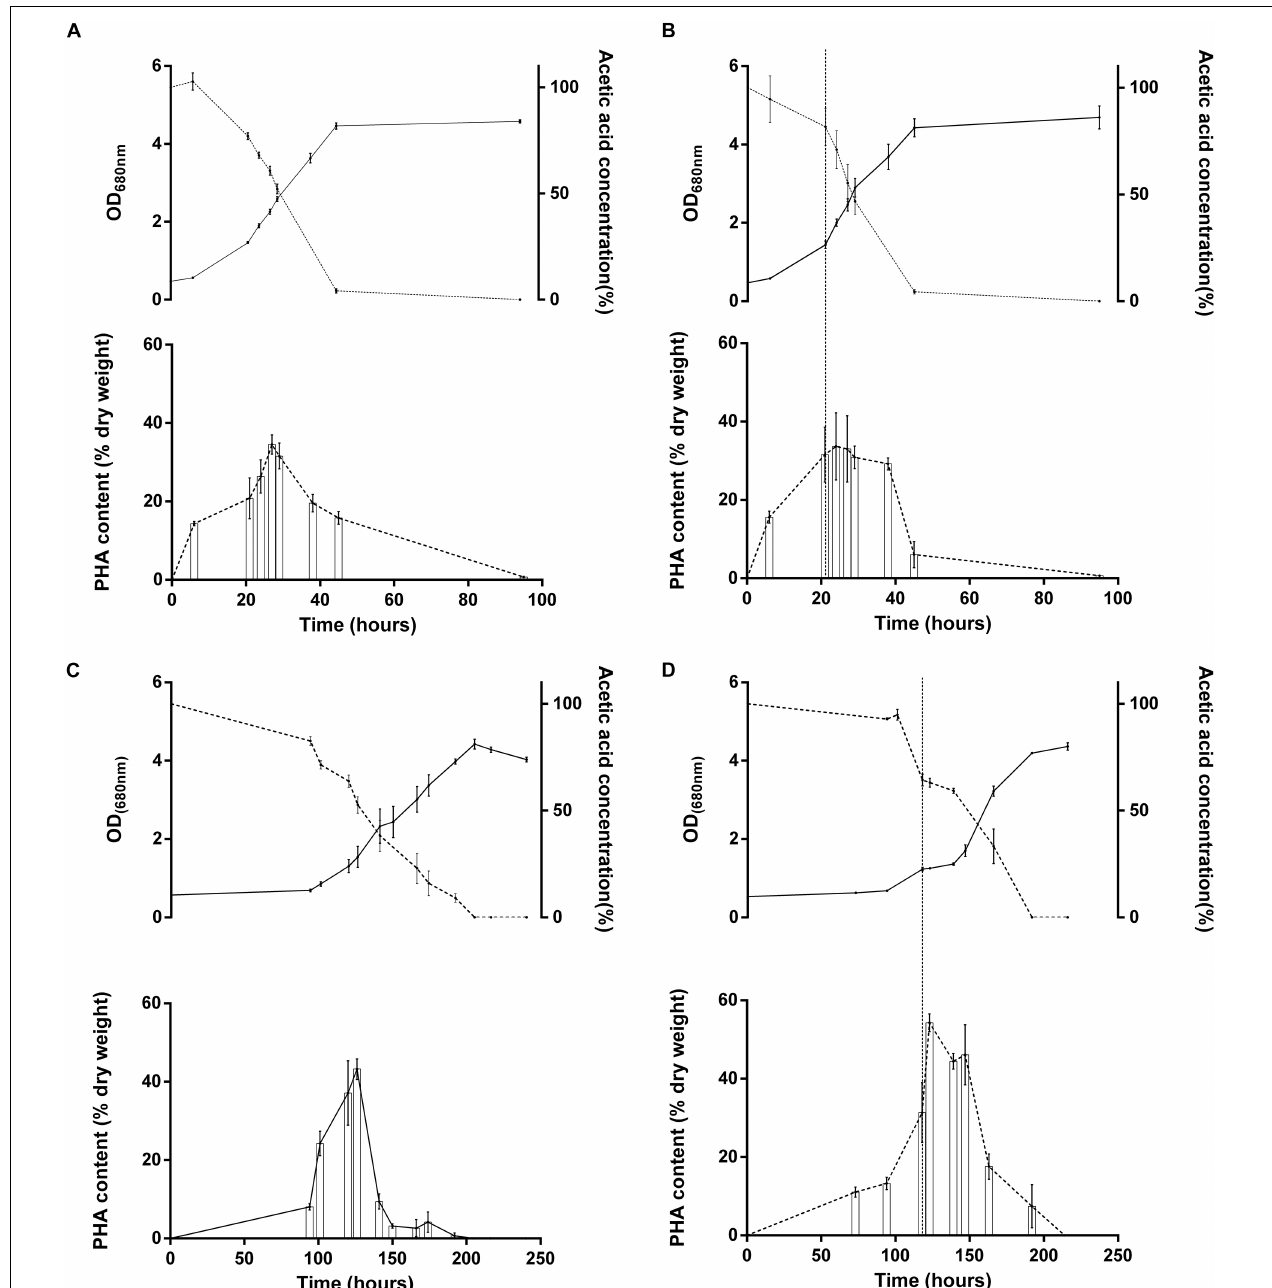
FIGURE 7 | Growth (full line; upper panel), acetate consumption (dotted line, upper panel) and PHA accumulation (lower panel) of Rs. rubrum for the acetate-competent strain (A,B) or Wild type strain (C,D) in presence of acetate supplemented with 3 mM HCO 3 − submitted (B,D) or not (A,C) to a light intensity increase from 50 to 150 µ mol photons/m 2 s. Vertical dotted line represents the light stress (B,D) N =